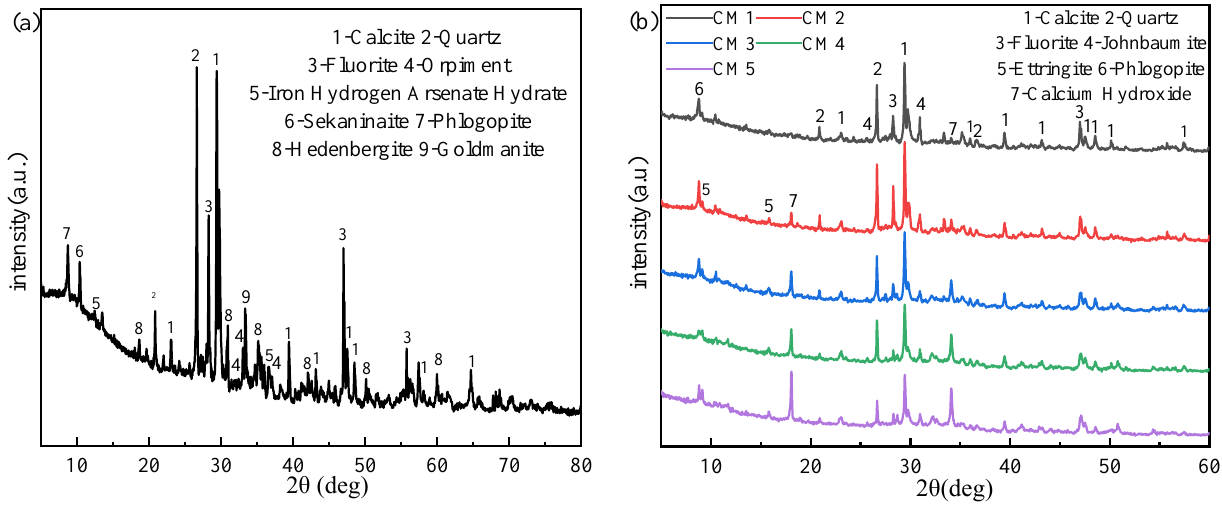
Figure 2. XRD spectra of tin tailing ( a ) and sample of CM1 to CM5 ( b ).